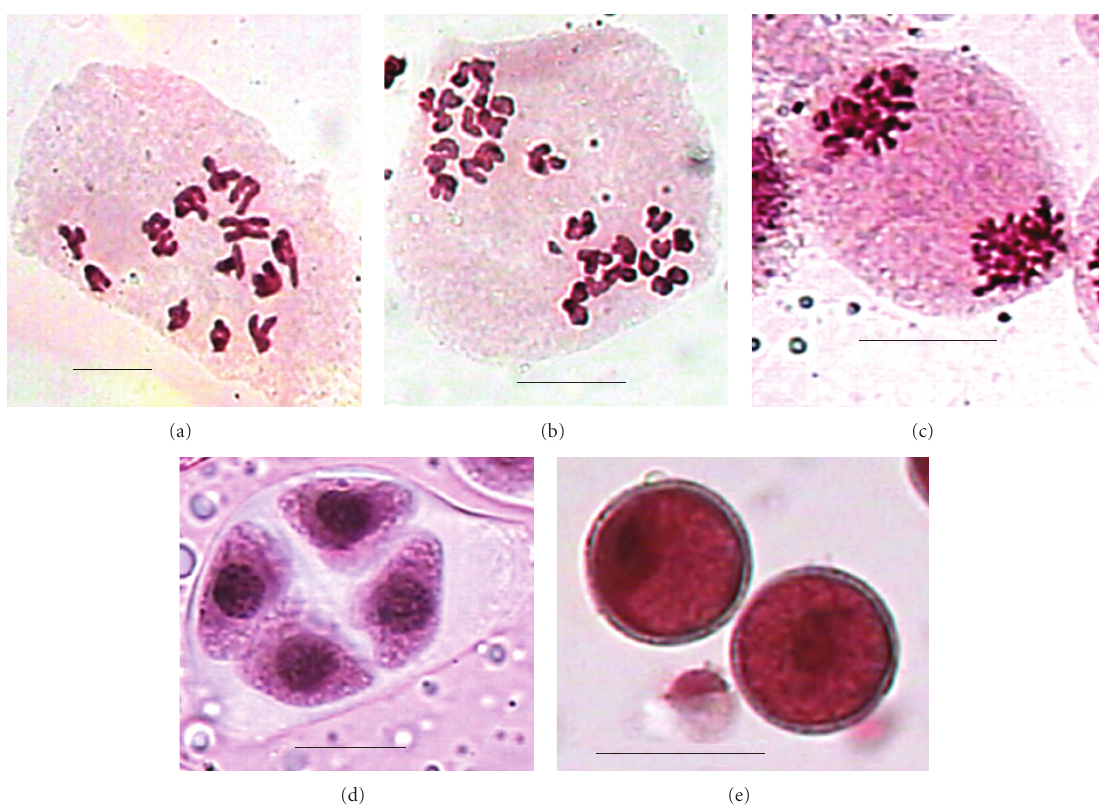
Figure 2: (a–e) Meiocytes with normal meiotic behaviour in R. laetus . (a) A PMC with 14 bivalents at diakinesis. (b) A PMC showing 14:14 chromosomes distributions at A-I. (c) A PMC showing two poles at A-I. (d) A tetrad with four n (reduced) microspores. (e) Apparently stained fertile n (reduced) pollen grains. Scale bar = 10 µ m (a–d); 20 µ m